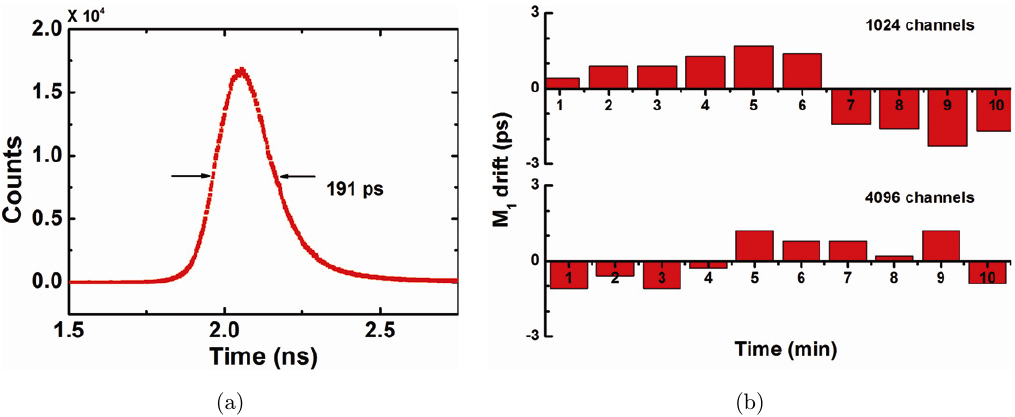
Fig. 1. (a) The IRF pro¯le of our TCSPC-FLIM system, and (b) the M 1 drift recorded with di®erent time